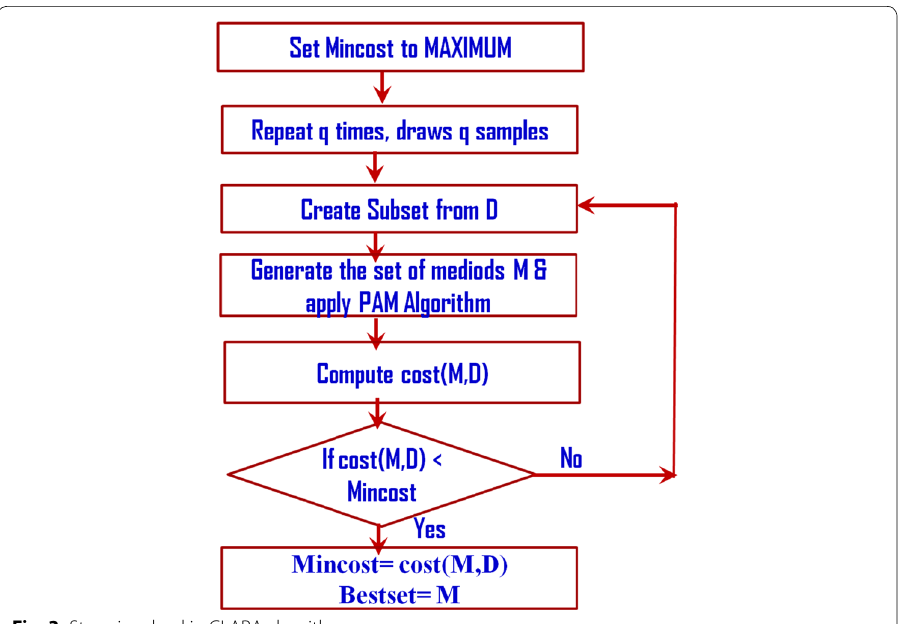
Fig. 3 Steps involved in CLARA